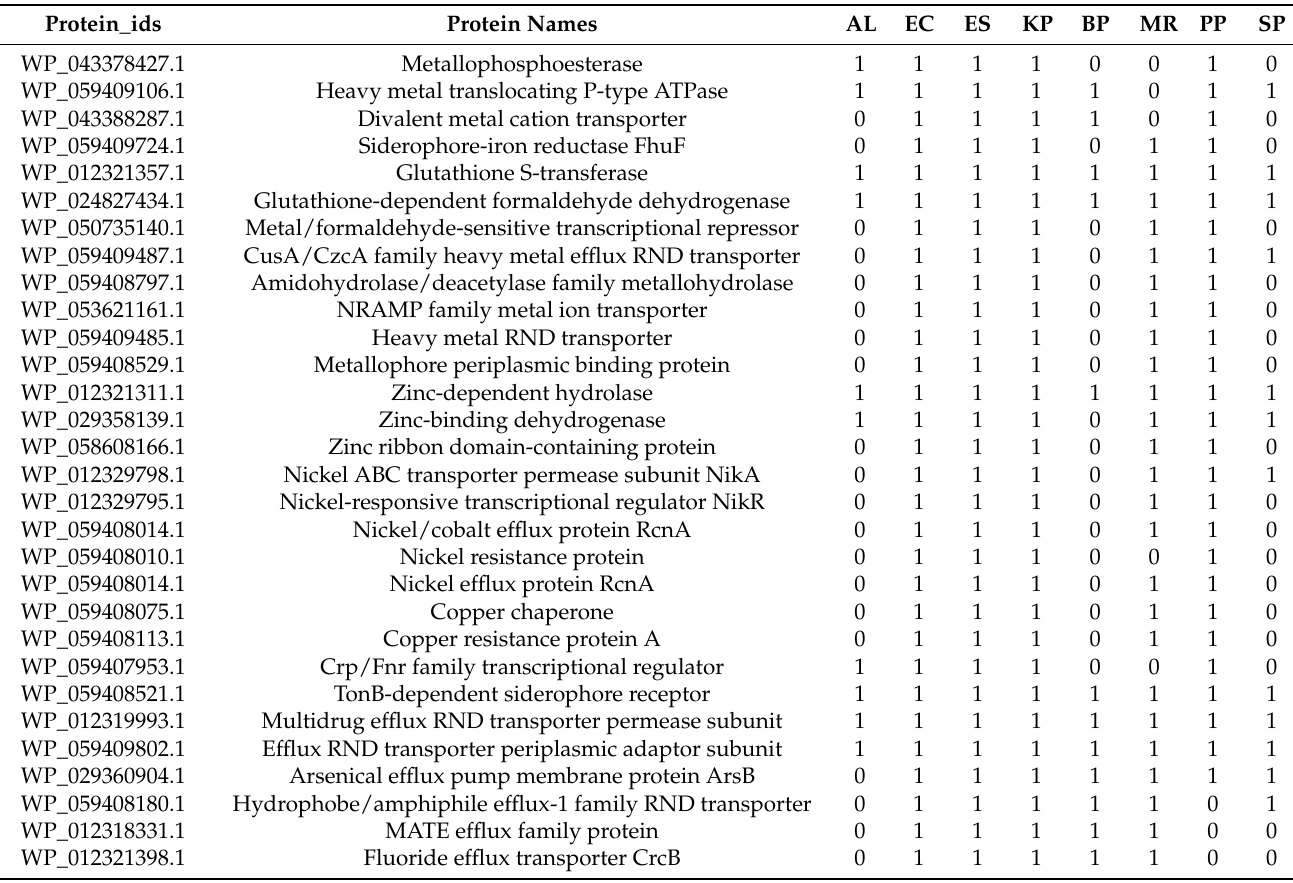
Table 2. Summary of proteins putatively responsible for heavy metal resistance of copper, nickel, zinc, and siderophore production in Methylobacterium radiotolerans MAMP 4754.